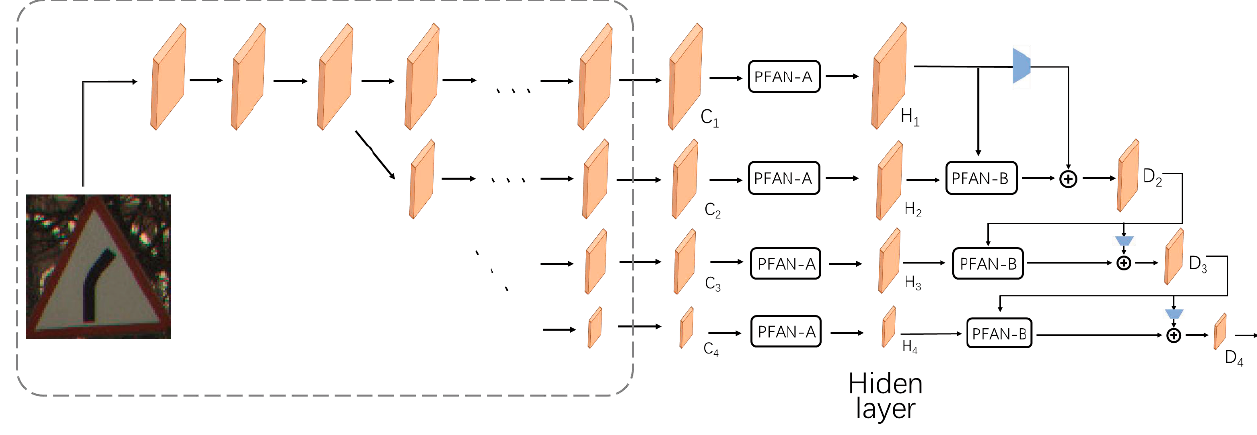
Figure 5. The framework of the PFAN for image classification we propose. Once {C 1 , C 2 , C 3 , C 4 } has been obtained, we further generate the hidden layer H f , and then D 1 , D 2 ... progressively. “ ” denotes down-sampling implemented by 2 × 2 MaxPooling and “ ” denotes an element-wise sum. In the dashed rectangle, the horizontal arrow represents the bottleneck or the basic block operation, and the diagonally downward arrow indicates down-sampling implemented by 2 × 2 MaxPooling. Arrows outside the rectangle only represent the data flow direction.